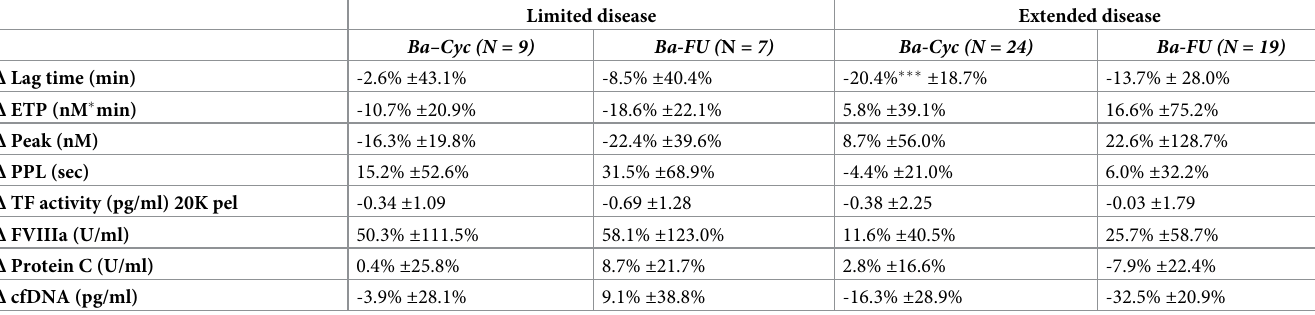
Table 3. Percentage deviation from baseline in all the different measured values during treatment.